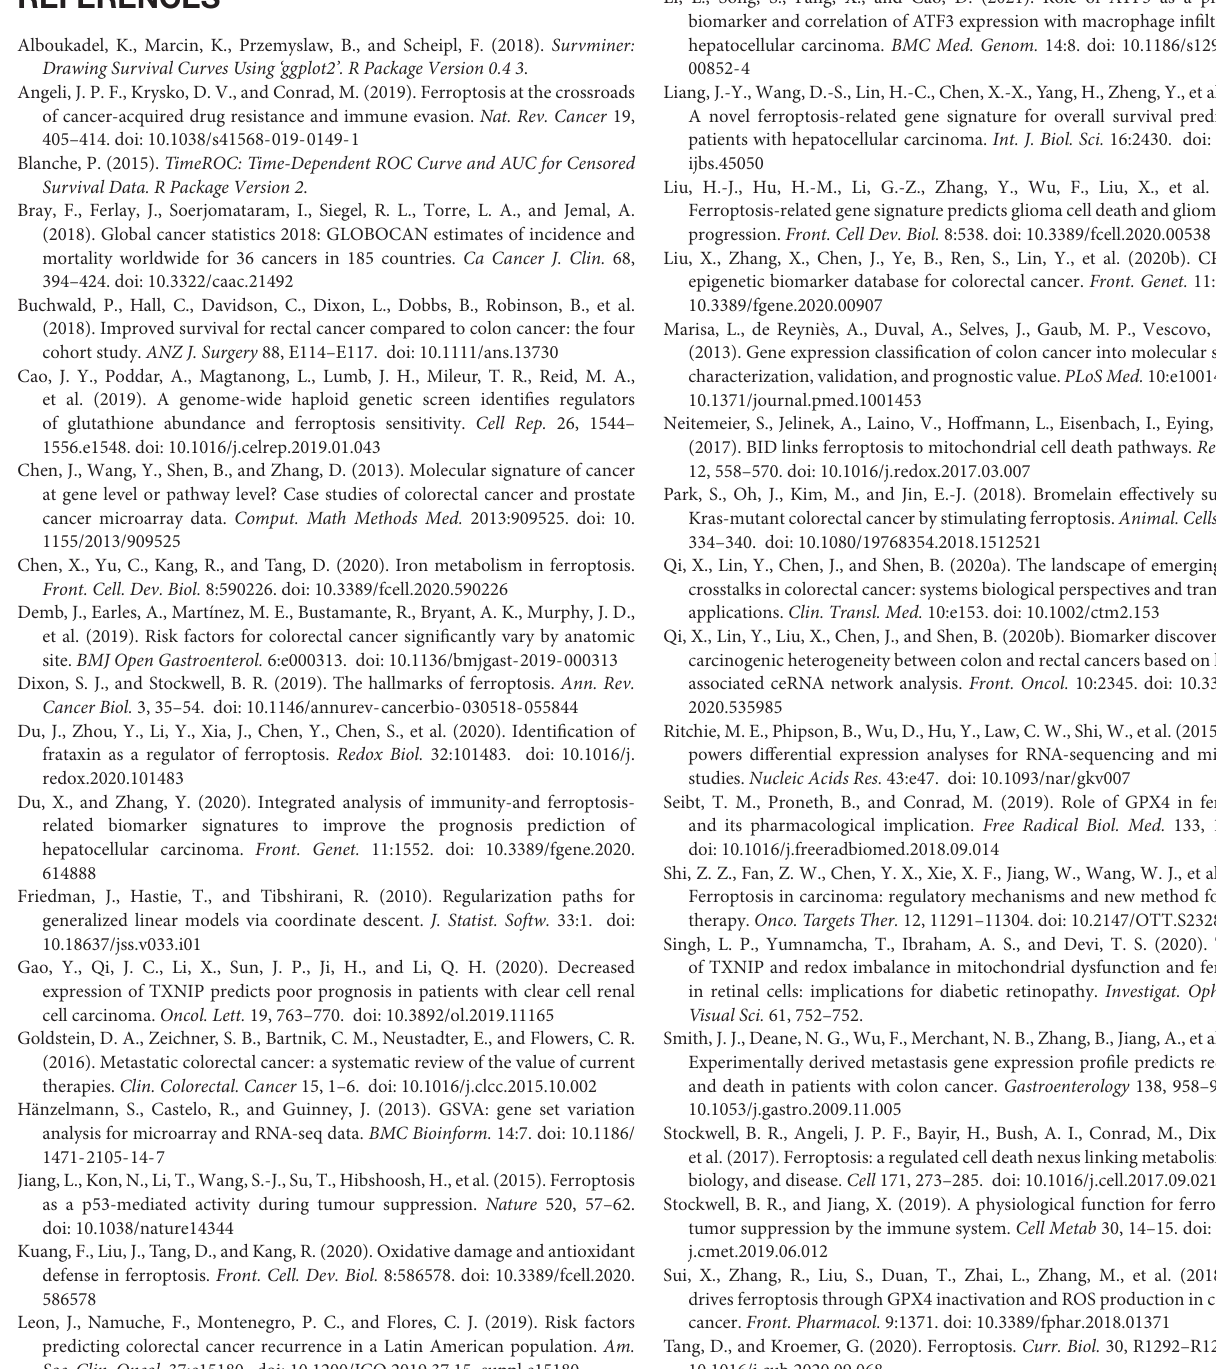
Supplementary Table 1 | The FRGs retrieved from the public FerrDb database. Supplementary Table 2 | Differential expression pattern of prognostic FRGs between tumor and normal control